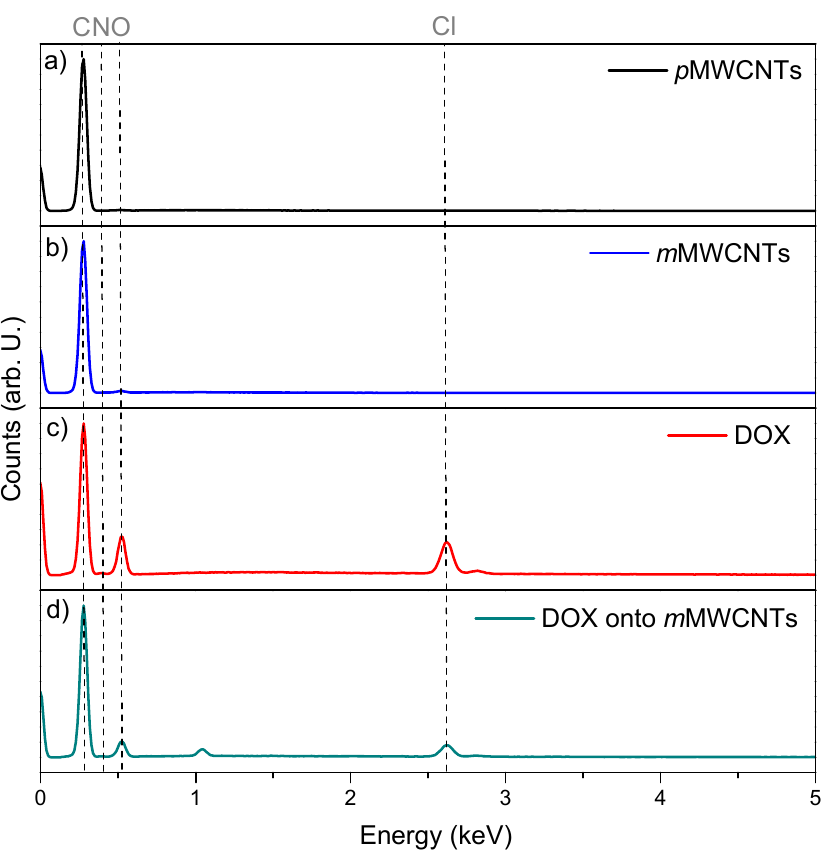
Figure 3. SEM images of ( a ) p MWCNTs ( b ) m MWCNTs and ( c ) m MWCNTs with adsorbed DOX.